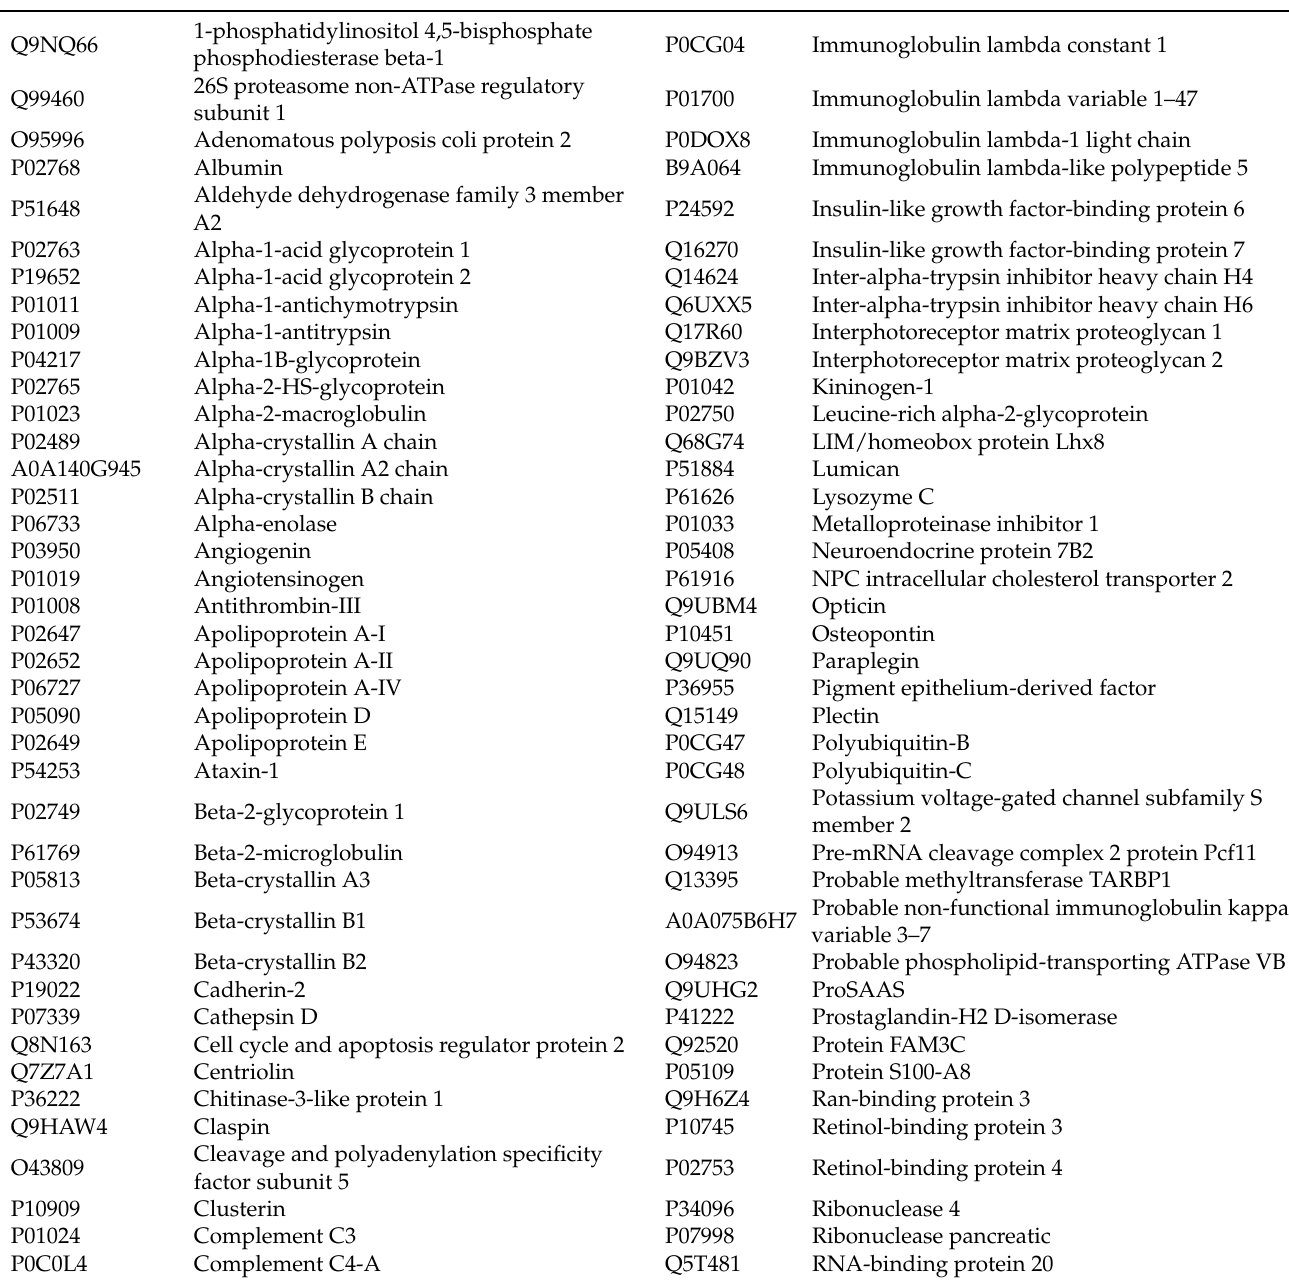
Table 2. List of aqueous humor (AH) proteins identified by